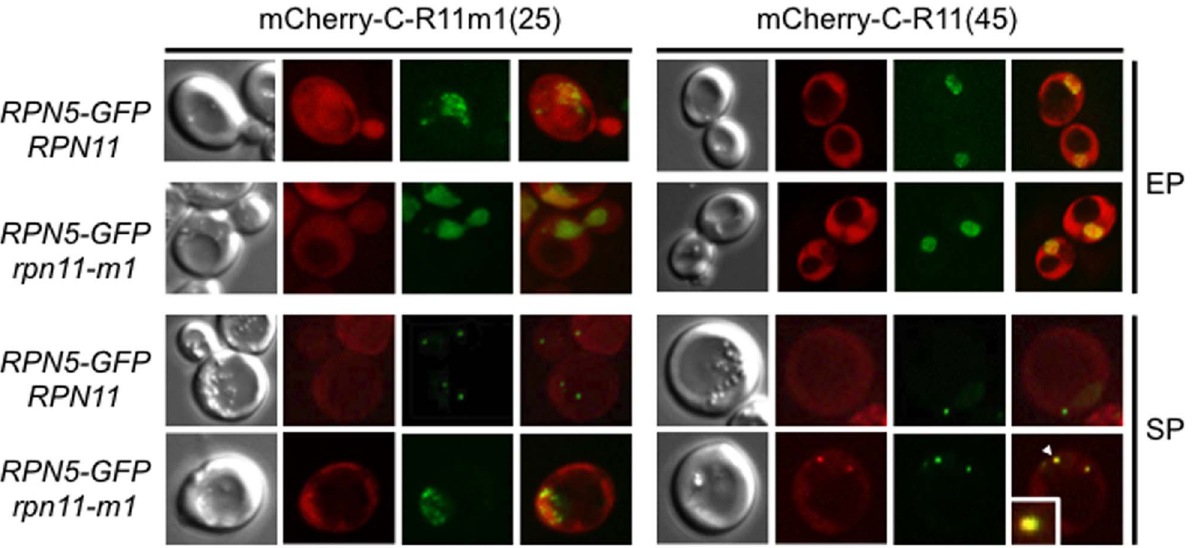
Figure 7. Co-localization of Rpn5-GFP and the mCherry fused to C-R11(45) or C-R11m1(25) in rpn11-m1 cells. Wild type and rpn11-m1 cells co-expressing Rpn5-GFP and the mCherry fused to the Rpn11 carboxyl terminus domain (mCherry-C-R11(45)) or to its mutated form (mCherry- CR11m1(25)) were grown in YPDA medium at 26 u C and examined by fluorescence microscopy. Typical co-localization images obtained after one day of culture (exponential phase, EP) or after five days in stationary phase (SP). The white arrow in the last image points to a PSG, which is enlarged in the same image.